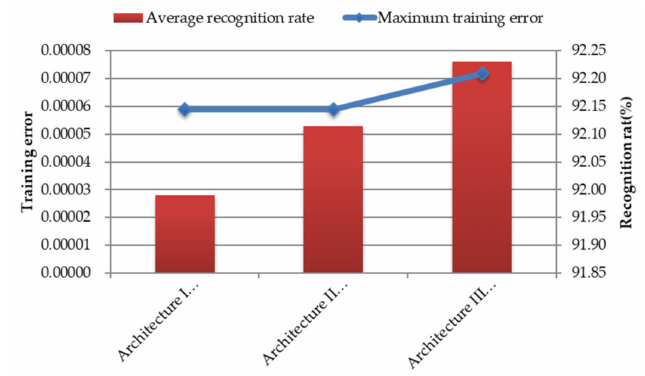
Figure 16. Analysis of training and test data